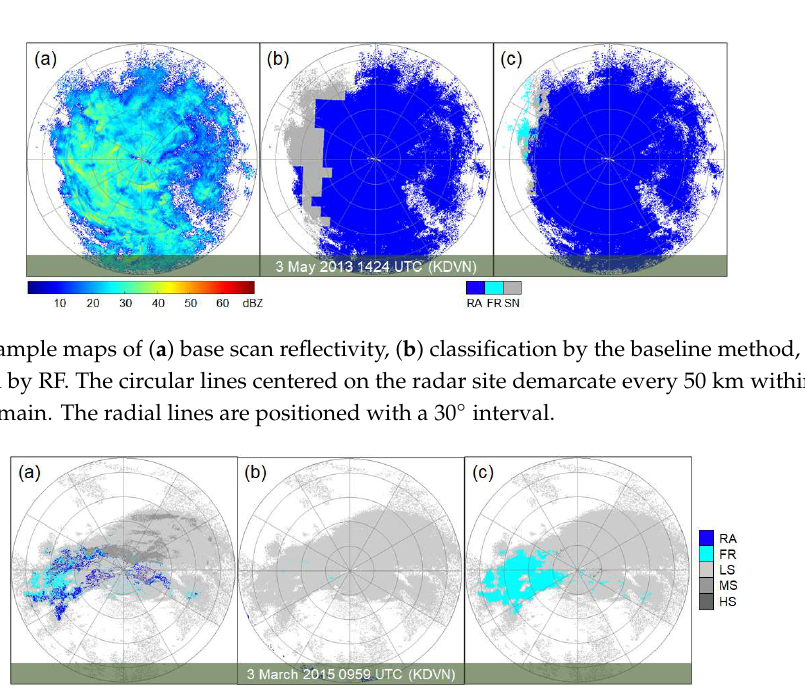
Figure 9. Example classification maps generated from ( a ) k NN, ( b ) RF, and ( c ) MLP.